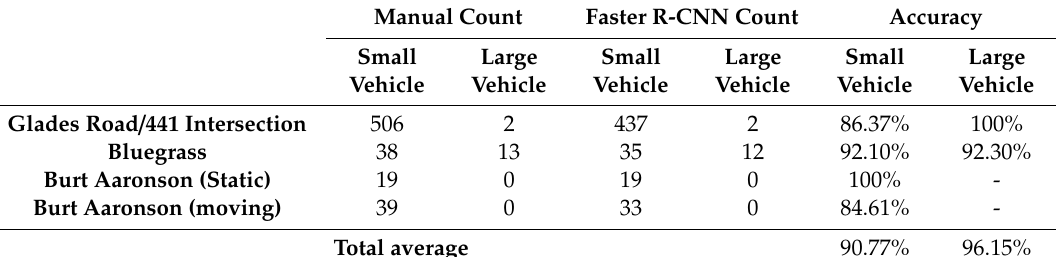
Table 1. Vehicle detection results.